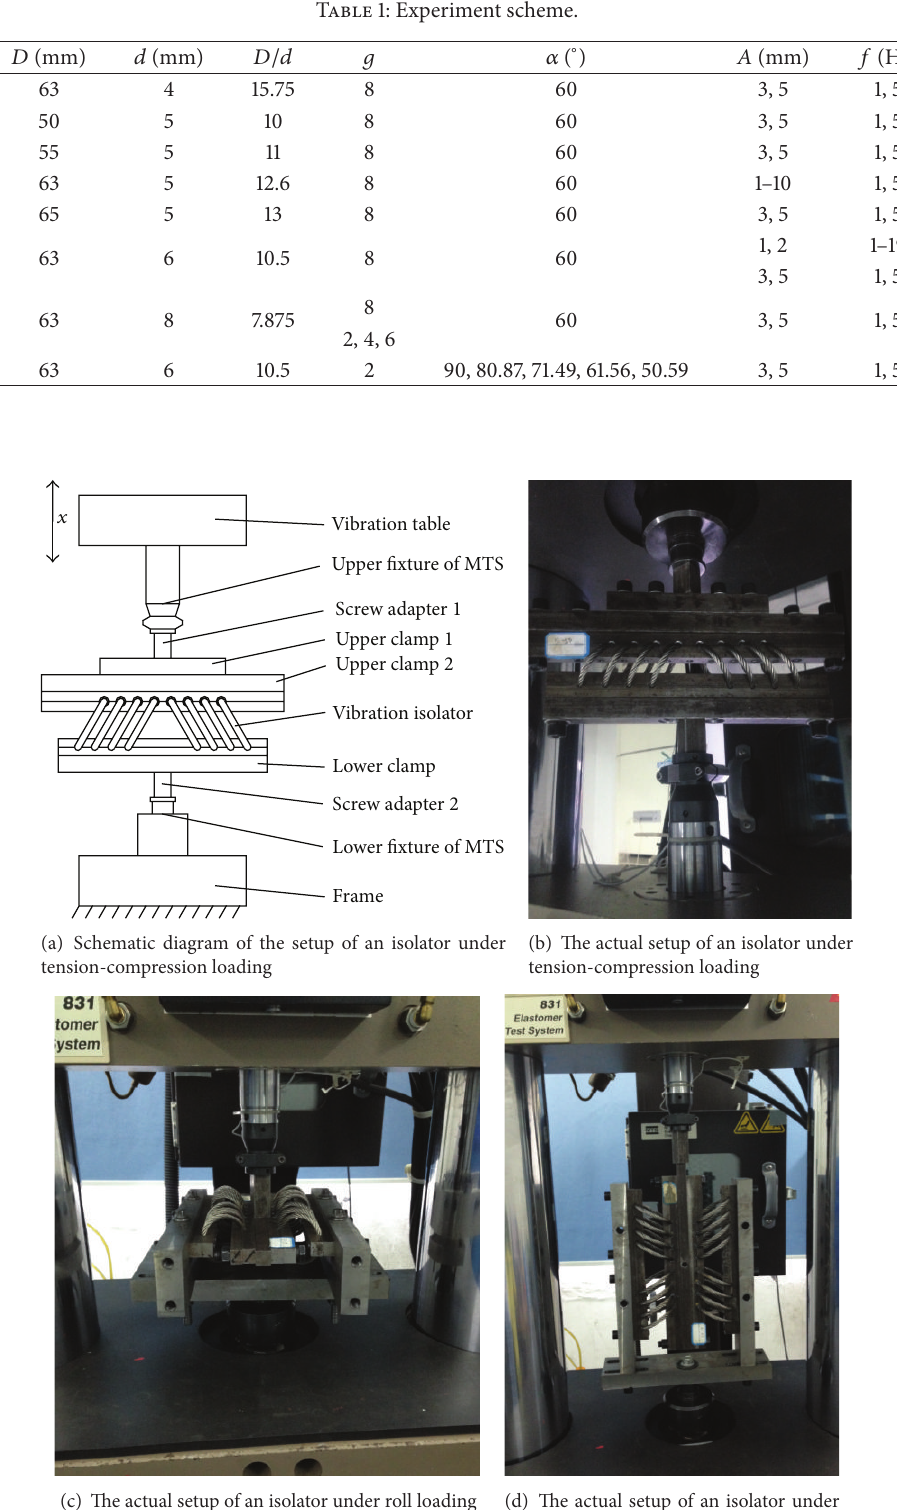
Figure 3: Setup of the